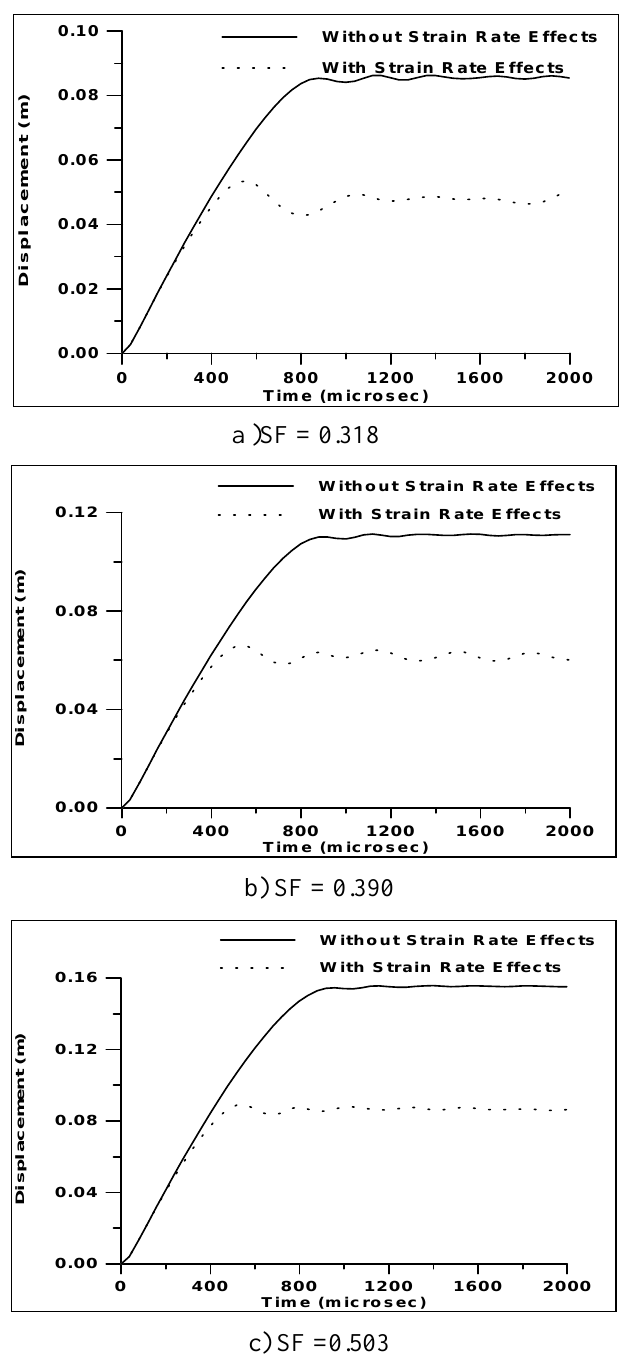
Fig. 9. Displacement time history for h/l = 0 . 0